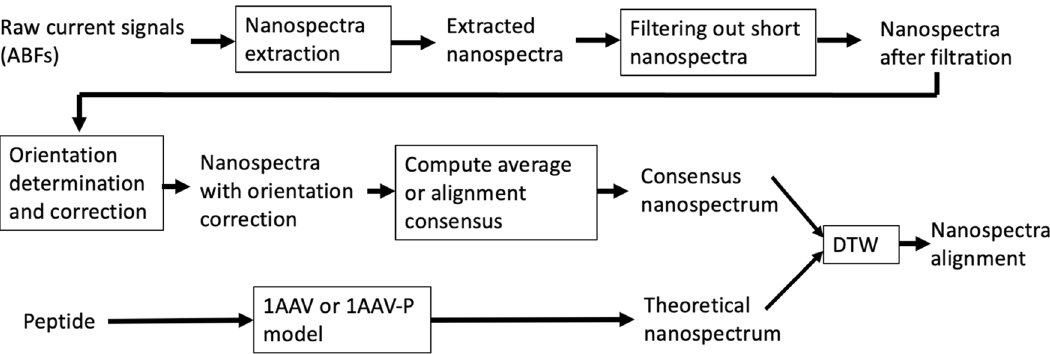
Figure 2. Overall scheme of nanospectral data analysis. Raw current blockade signals stored in ABFs are analyzed by a homemade software package based on OpenNanopore to extract nanospectra, which are filtered to remove those with short duration times. The orientations of nanospectra are determined by comparing original and flipped empirical nanospectra with the theoretical nanospectra of the peptide, and backward empirical nanospectra are flipped. The averaging or progressive alignment method is employed to generate a consensus empirical nanospectrum. A theoretical nanospectrum is generated using the 1AAV or 1AAV-P model. Finally, the empirical consensus nanospectrum is aligned with the theoretical nanospectrum using DTW to find an alignment between the two nanospectra, and the PCC of the aligned nanospectra is